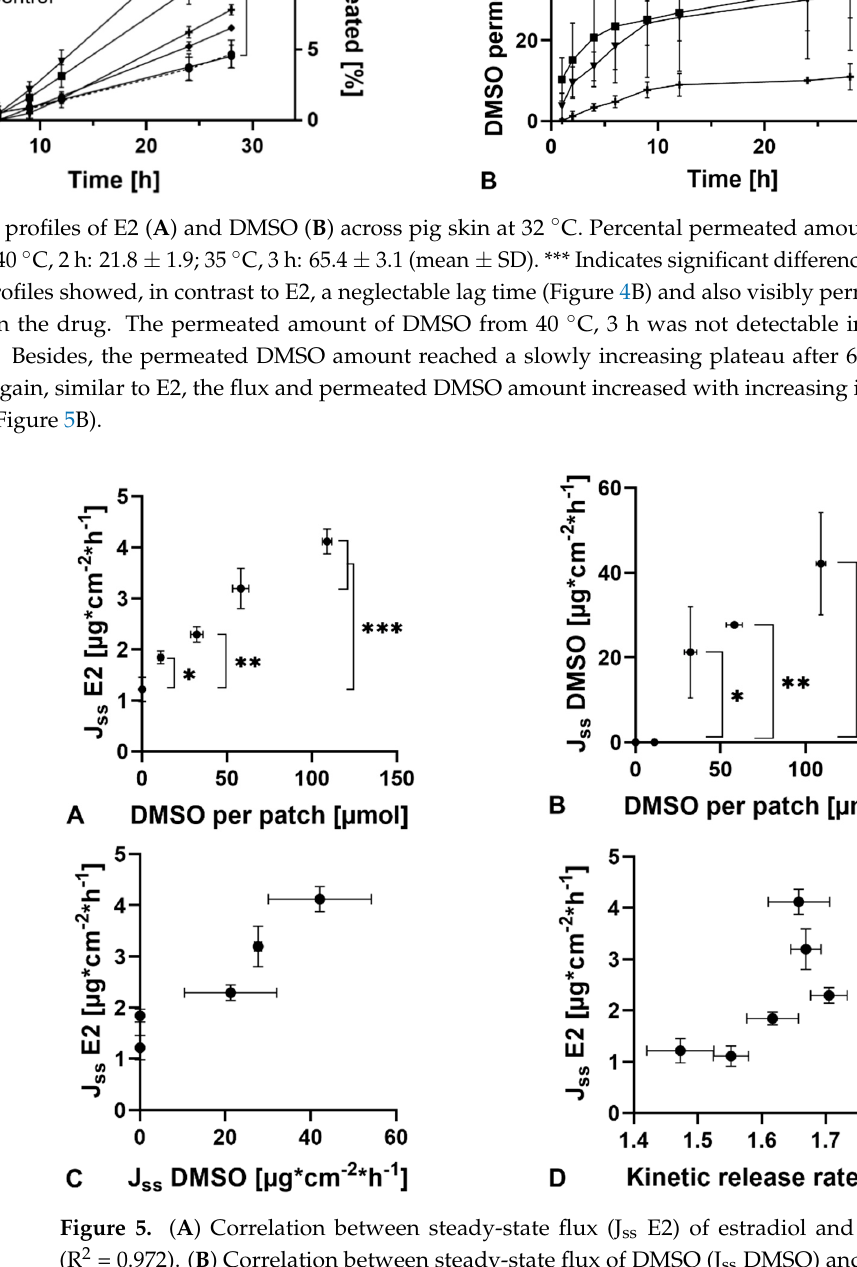
Figure 6. Distribution of E2 after 28 h permeation experiments in skin and patch and through per- meation into the acceptor compartment of Franz cells. 3.3. Storage Stability The absence of recrystallization after six months for all DMSO-based formulations regardless of the storage conditions was confirmed by XRPD (data not shown). In terms of DMSO loss, patches revealed to be stable during the first month under all test condi- tions as DMSO-content did not differ significantly (Figure 7). The benefit of low tempera- tures was minor as during longer periods, significant DMSO loss occurred of all formula- tions when stored at 4 °C (sealed, Figure 7A). The slightest change in DMSO content was found when patches were stored sealed at 25 °C/60% RH (Figure 7B). Generally, a more distinct reduction of DMSO content in patches was found for those with the initially high- est amount (35 °C, 3 h), the lowest loss for those with the lower initial DMSO content. Accordingly, after three months at 25 °C/60% RH (sealed), 40 °C, 2 h and 35 °C, 4 h patches still did not show statistically significant DMSO losses. Generally, the DMSO loss during storage translated into lower E2 permeation through the skin. While six months storage under any storage conditions led to a significant lowering of E2 permeation, E2 permea- tion did not significantly change in patches 40 °C, 2 h and 35 °C, 4 h after three months (Figure 8).